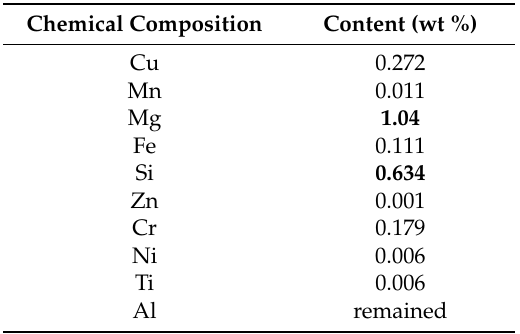
Table 1. Chemical composition of AA6061 powder (wt %).